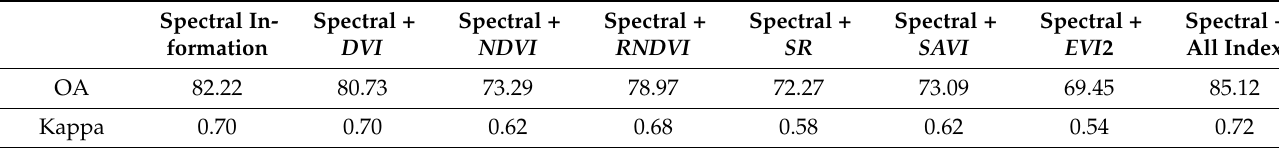
Table 5. Classification results using the k-means classifier. Table 6. Classification results using the random forest